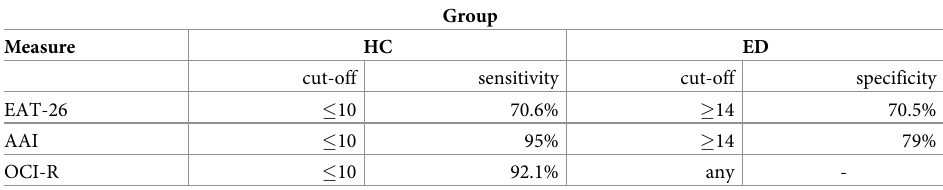
Table 1. Cut-off points for ED and HC on EAT-26, AAI, and OCI-R questionnaires. Group Measure HC ED cut-off sensitivity cut-off specificity EAT-26 � 10 70.6% � 14 70.5% AAI � 10 95% � 14 79% OCI-R � 10 92.1% any - For each cut-off a sensitivity measure is provided for HC a specificity measure for